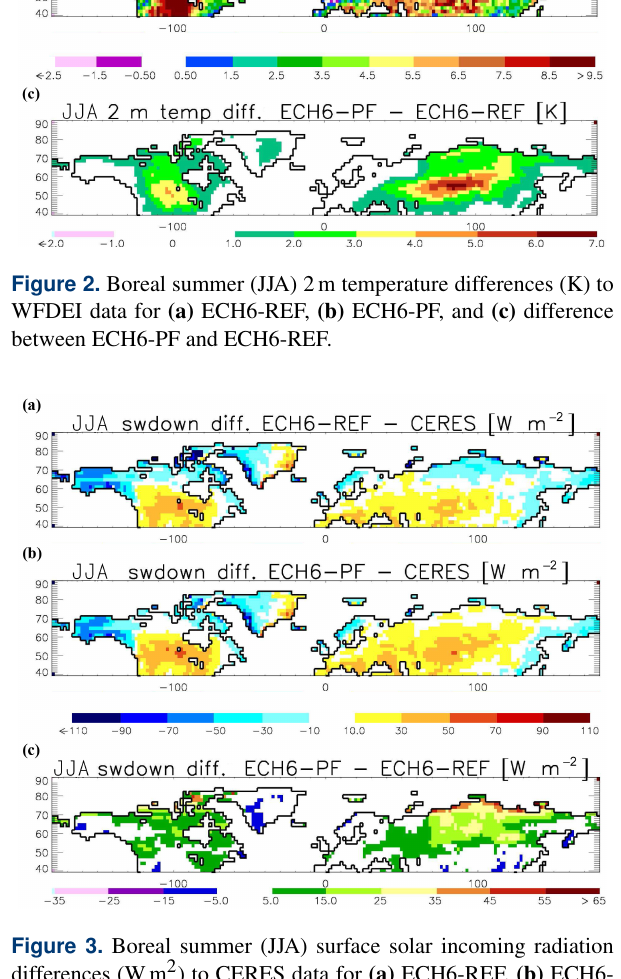
Figure 4. Catchments of the Baltic Sea and of the six largest Arctic rivers (from left to right: Mackenzie, Baltic Sea, Northern Dvina, Ob’, Yenisey, Lena,